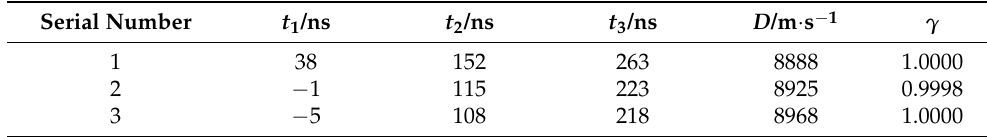
Table 5. Experimental data with L = 1 mm, a = 0.5